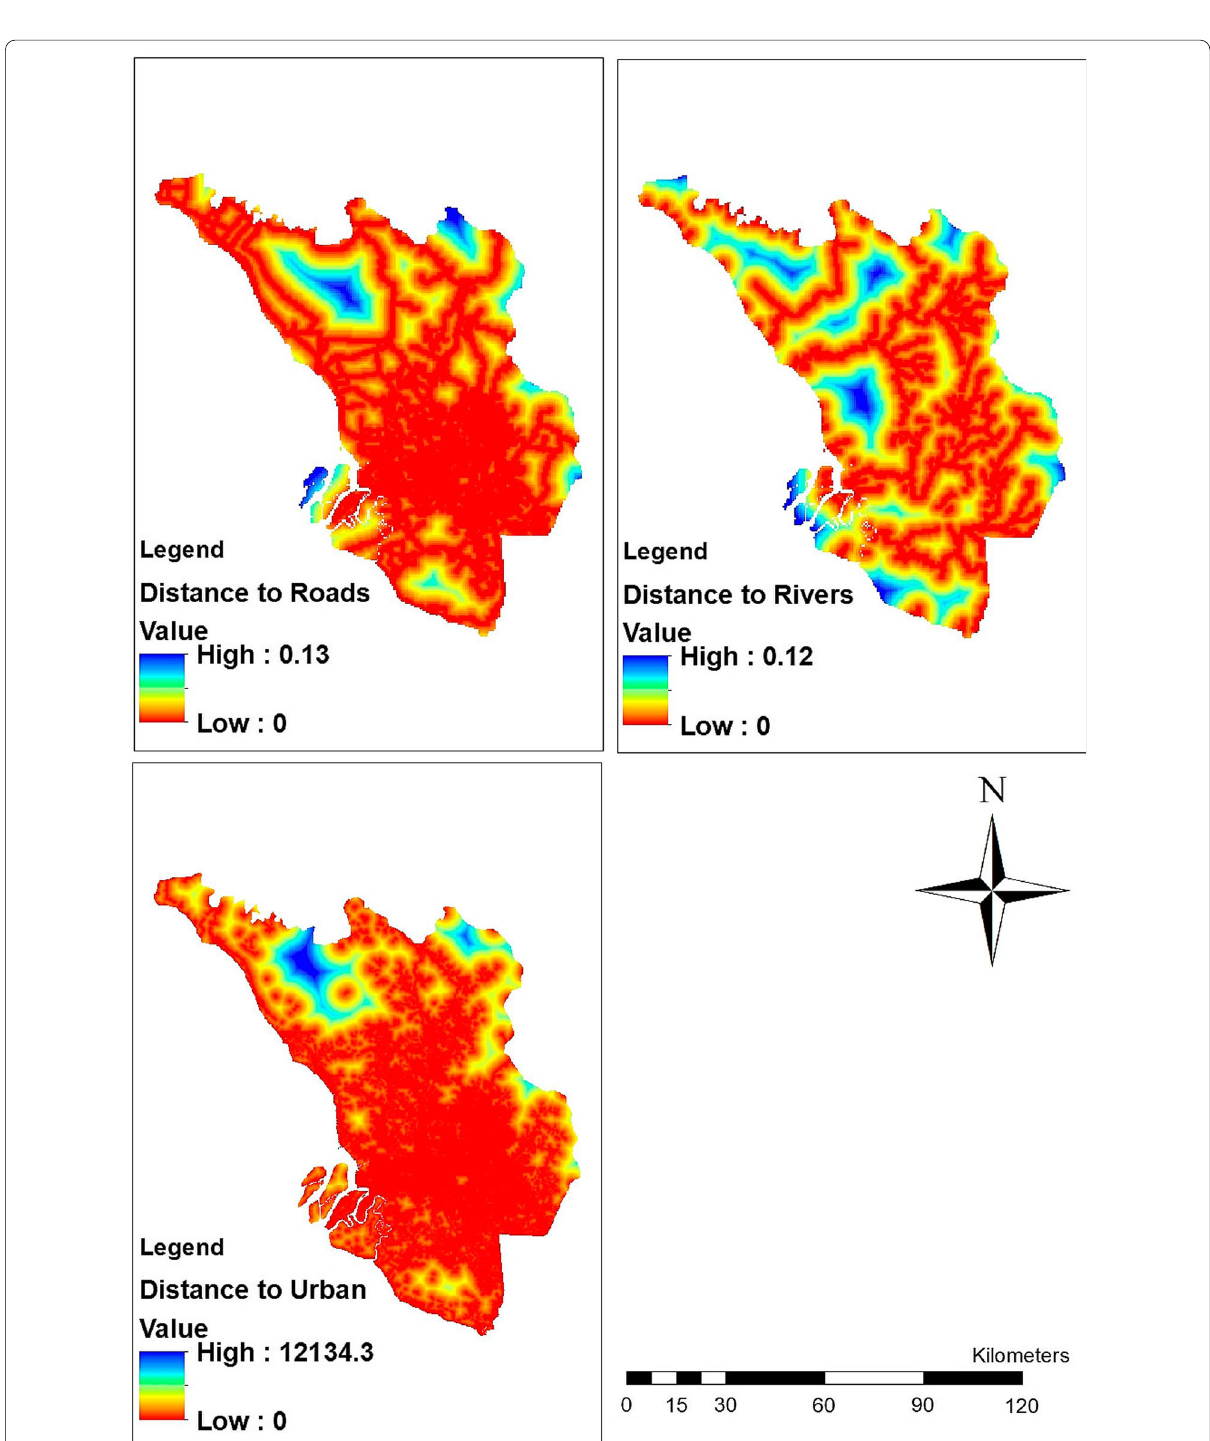
Fig. 2 Raster maps of distance to roads, distance to rivers, and distance to urban area, used as driver variables for the transition potential modelling